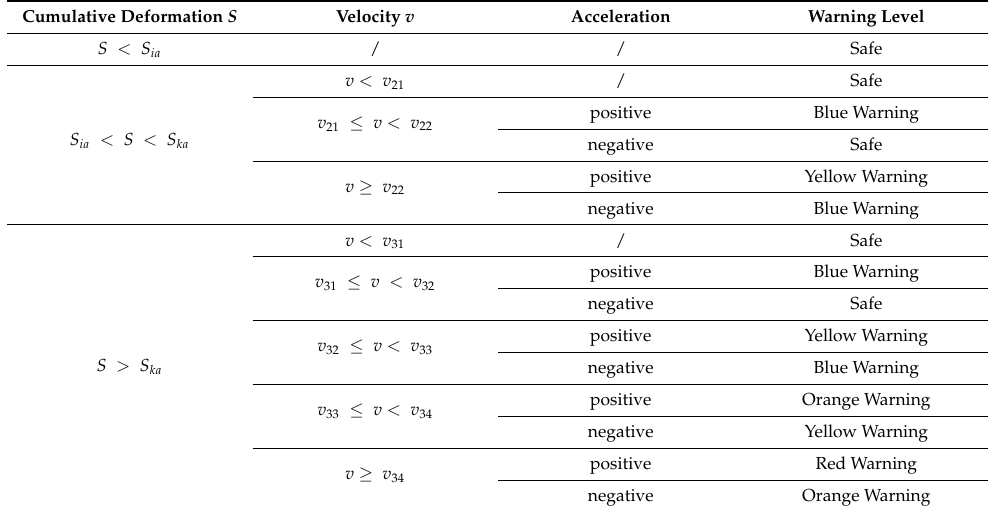
Table 1. Early warning levels obtained by the conventional early warning